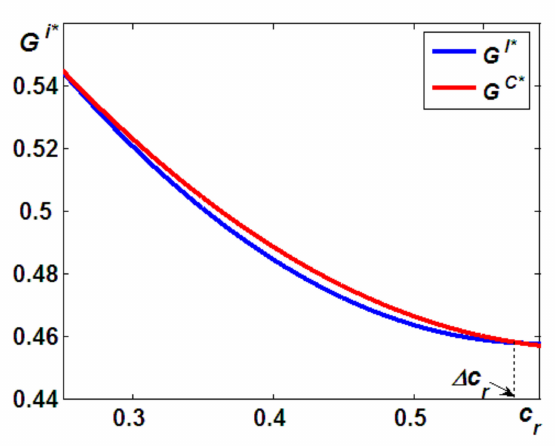
Figure 7. Differences in the total carbon emission